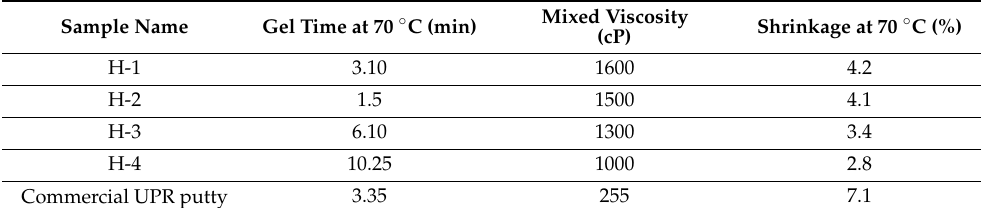
Table 4. Gel time, viscosity, and shrinkage rate of the epoxy putties.